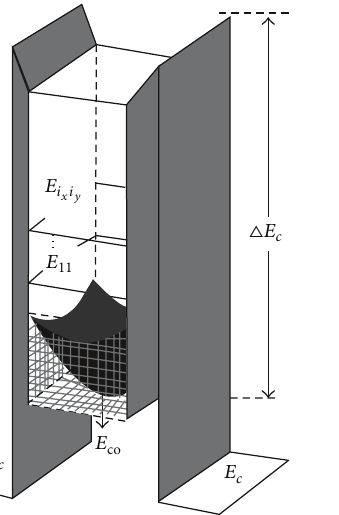
Figure 2: Band diagram perpendicular to the gate-square well potential of a GAA silicon nanowire